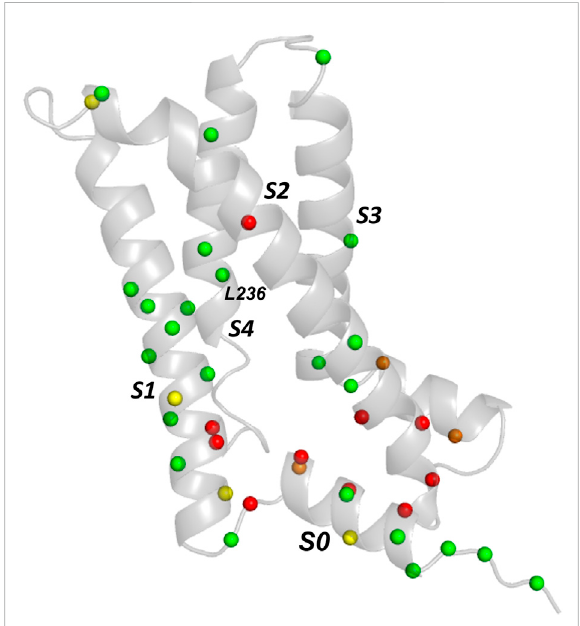
FIGURE 3 Comparison of experimental traf fi cking data for KCNQ1 VSD with EC analysis. Traf fi cking data is from (Huang et al., 2018) and the EC data for comparison is from Table 1. Green and red spheres denote matches between EC data and traf fi cking data. Green spheres are C α carbons of residues having variants with moderate to good traf fi cking ( > 40% WT) that are absent from the EC data set or, if present, are conservative mutations (Table 1). Red spheres denotevariantsthatmistraf fi c( < 40%WT)andarepresentintheEC set. Orange (poor traf fi cking/absent from EC set) and yellow spheres (moderate to good traf fi ckers present in the EC set with lower conservation scores) are mismatches between EC data and traf fi cking